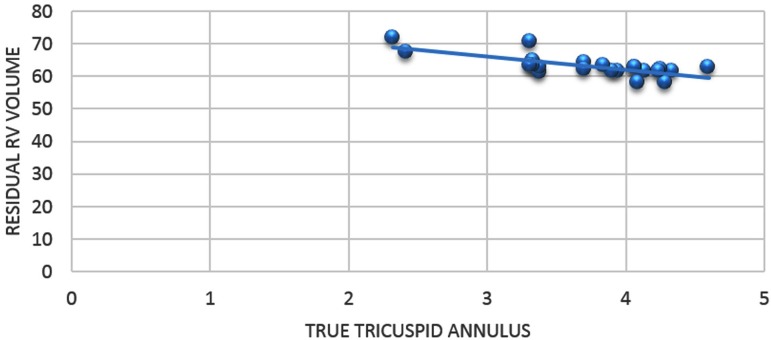
Correlation chart showing a negative correlation between TTA 'Z' score
and percentage reduction in right ventricular volume following repair
with a correlation coefficient of −0.83 (P value <0.01).RV=right ventricle; TTA=True tricuspid annulus